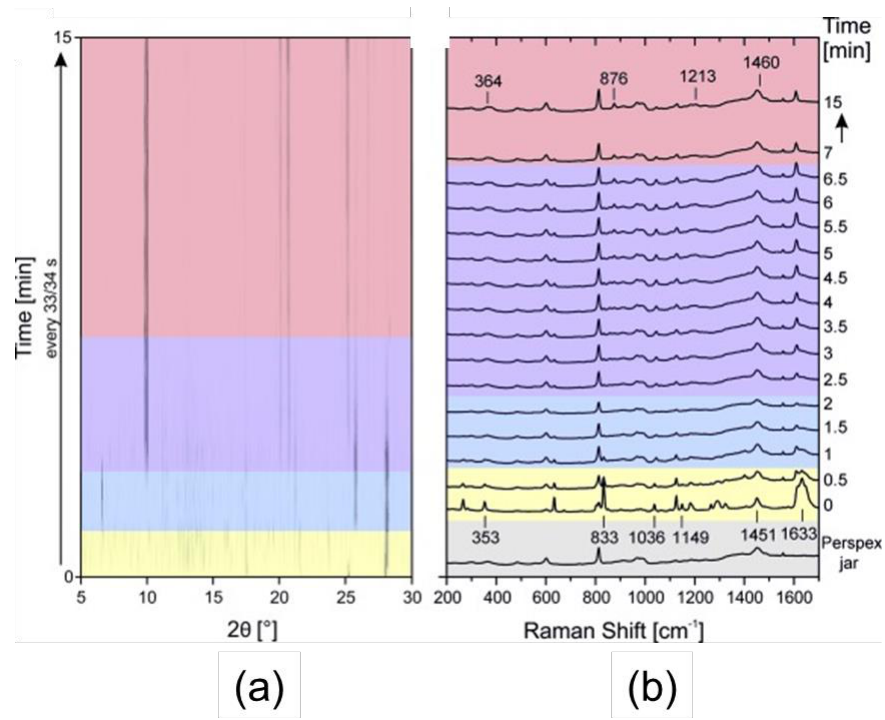
Figure 11. ( a ) In situ synchrotron diffraction patterns monitored during the synthesis of the metal– organic framework (H 2 Im)[Bi(1,4-bdc) 2 ], ( b ) in situ Raman spectra. The first Raman spectrum (gray) belongs to the empty Perspex jar, yellow: reactants, blue: intermediate phase and terephthalic acid, purple: product 2 and terephthalic acid, red: product. Reprinted with permission from [54]. Copyright 2014, John Wiley and Sons.